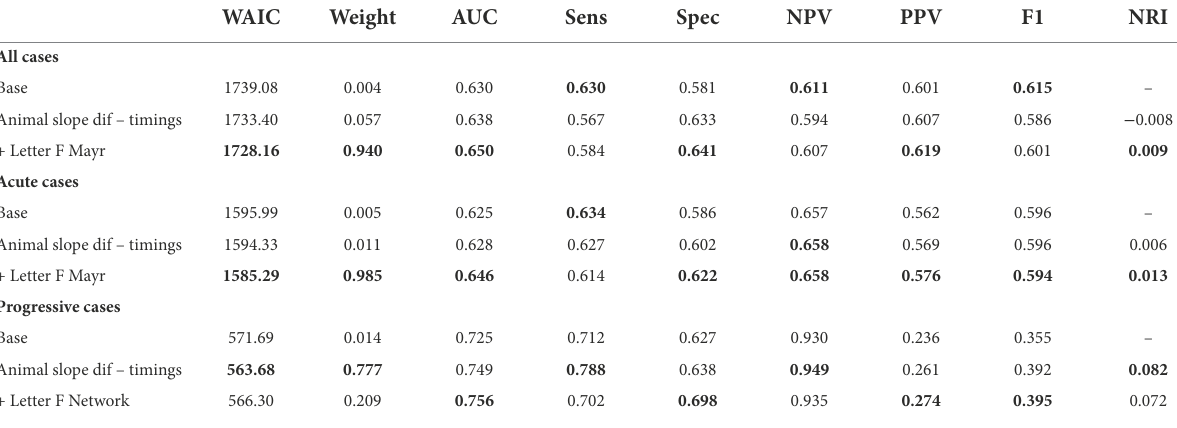
TABLE 6 Comparisons of combined models.